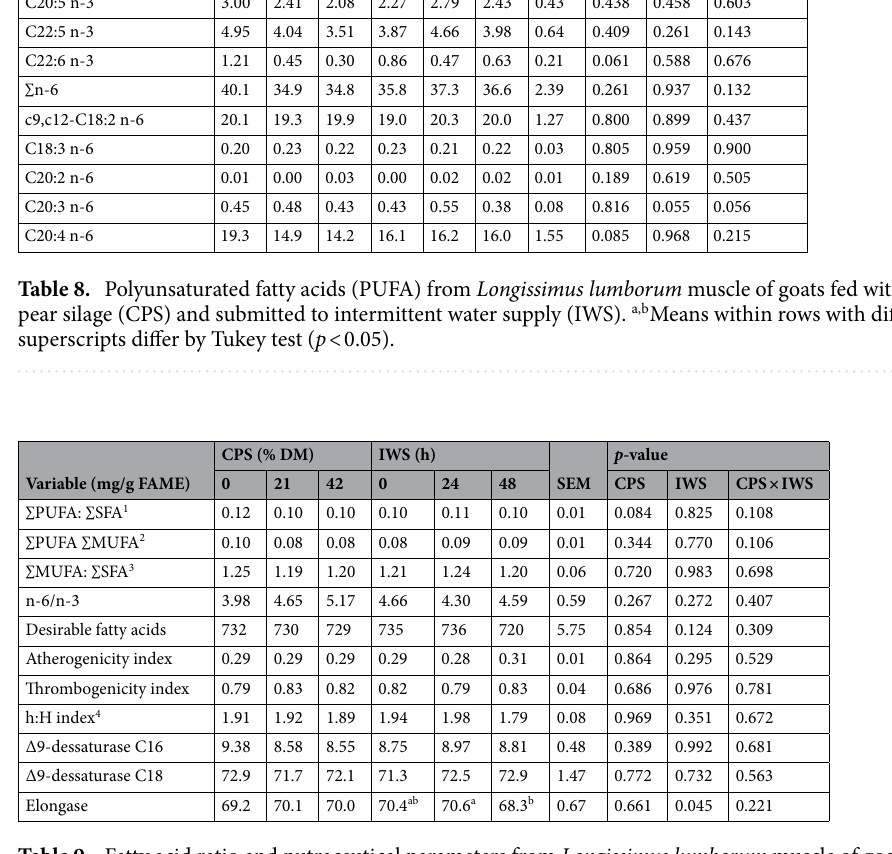
Table 9. Fatty acid ratio and nutraceutical parameters from Longissimus lumborum muscle of goats fed with cactus pear silage (CPS) and submitted to intermittent water supply (IWS). a,b Means within rows with different letter superscripts differ by Tukey test ( p < 0.05). 1 Ratio of polyunsaturated fatty acids to saturated fatty acids. 2 Ratio of polyunsaturated fatty acids to monounsaturated fatty acids. 3 Ratio of monounsaturated fatty acids to saturated fatty acids. 4 Ratio of hypocholesterolemic to hypercholesterolemic fatty